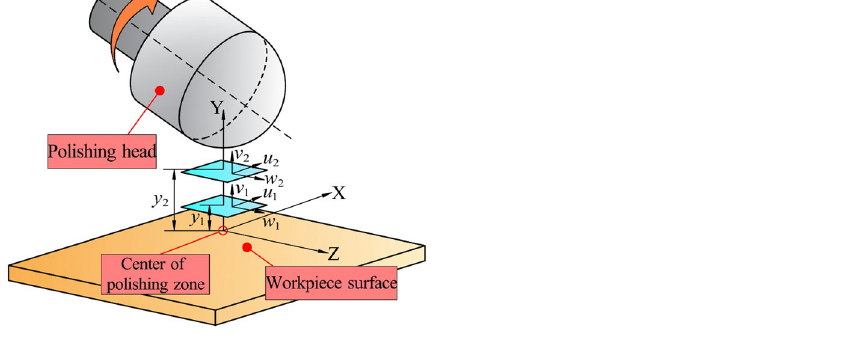
Figure 5. Schematic diagram of MR fluid hydrodynamic analysis model and coordinate